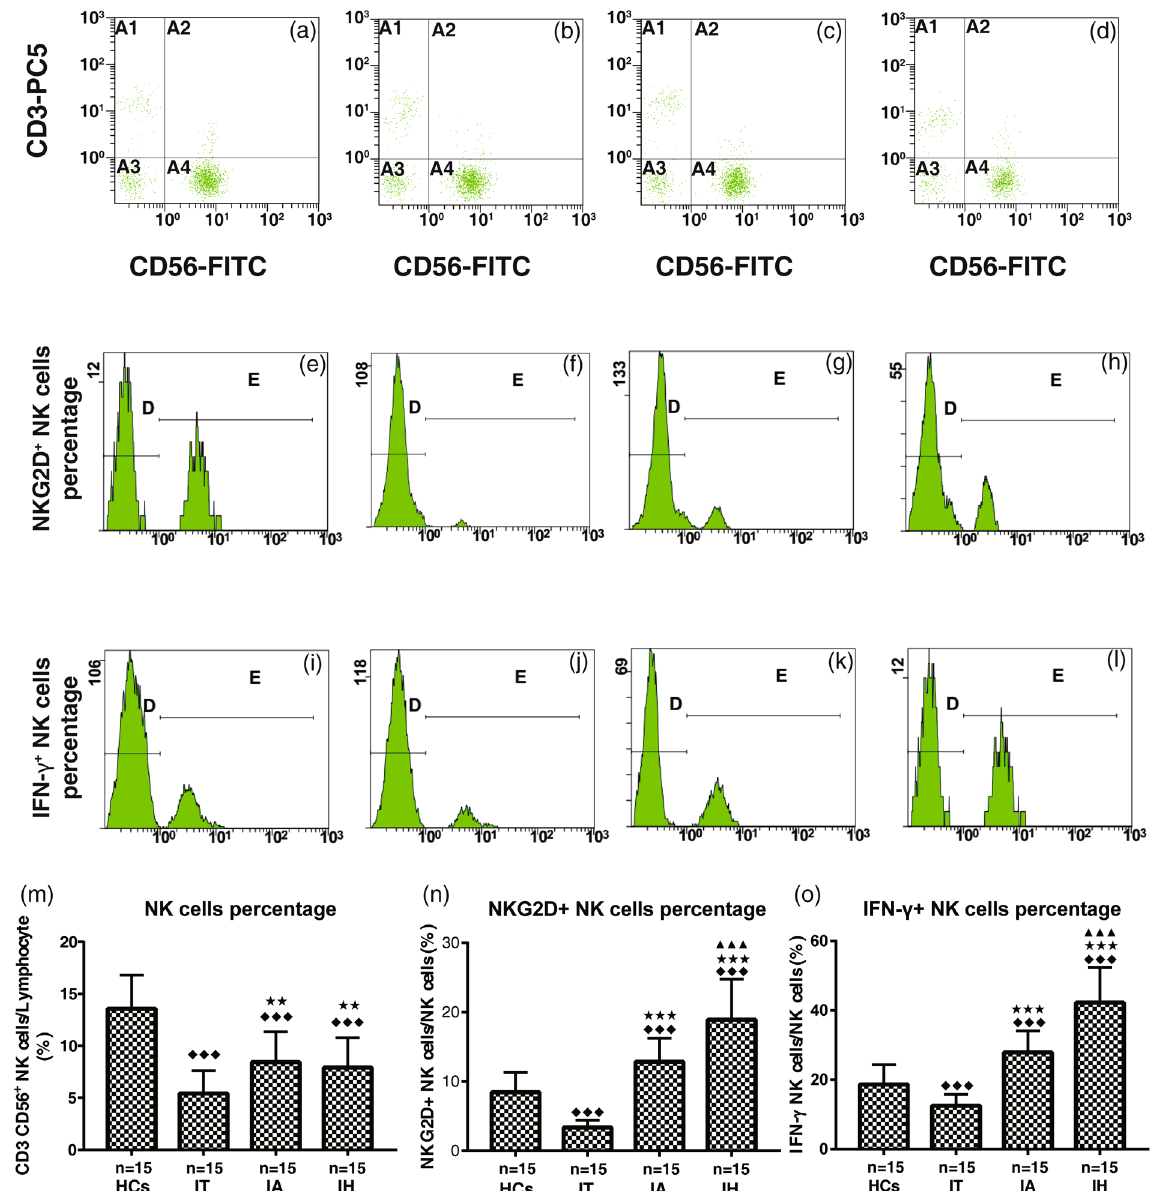
Figure 1. Percentages of NK (CD3 − CD56 + ) cells ( a – d , m ) in PBMC, NK cell group 2D receptor (NKG2D) + ( e – h , n ) and IFN- γ + ( i – l , o ) NK cells within total NK cells. HCs, healthy controls; IT, chronic HBV carriers; IA, CHB patients; IH, HBV-ACLF patients. Student-Newman-Keuls q test following one-way ANOVA were used for comparing percentages of NK cells, and Nemenyi test following Kruskal-Wallis H test were used for comparing percentages of NKG2D + and IFN- γ + NK cells between two groups. Compared with HCs group, ◆◆◆ P < 0.01; Compared with IT group, ★★★ P < 0.01, ★★ P < 0.05; Compared with IA group, ▲▲▲ P <